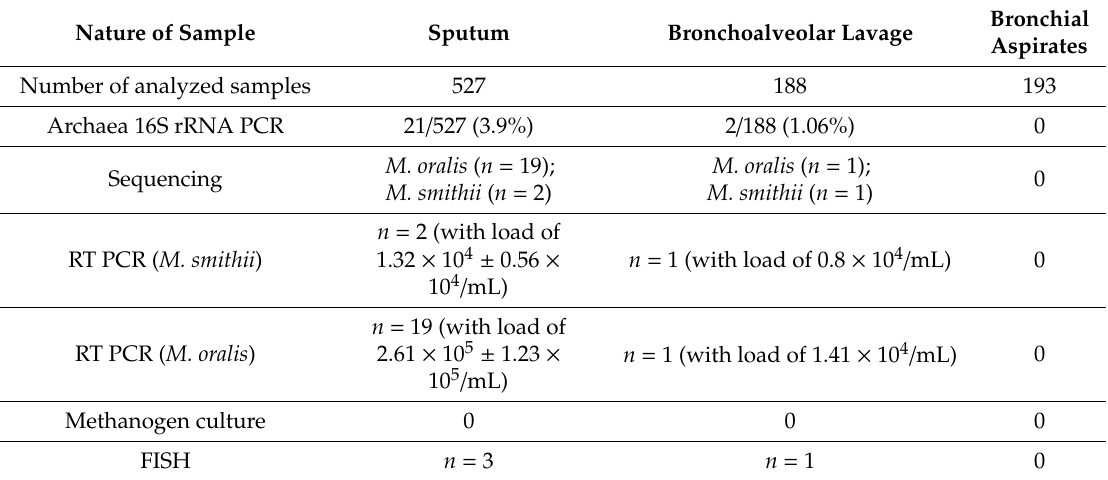
Table 1. Summary of the results obtained by PCR- based analysis, by culture method and by FISH. Nature of Sample Sputum Bronchoalveolar Lavage